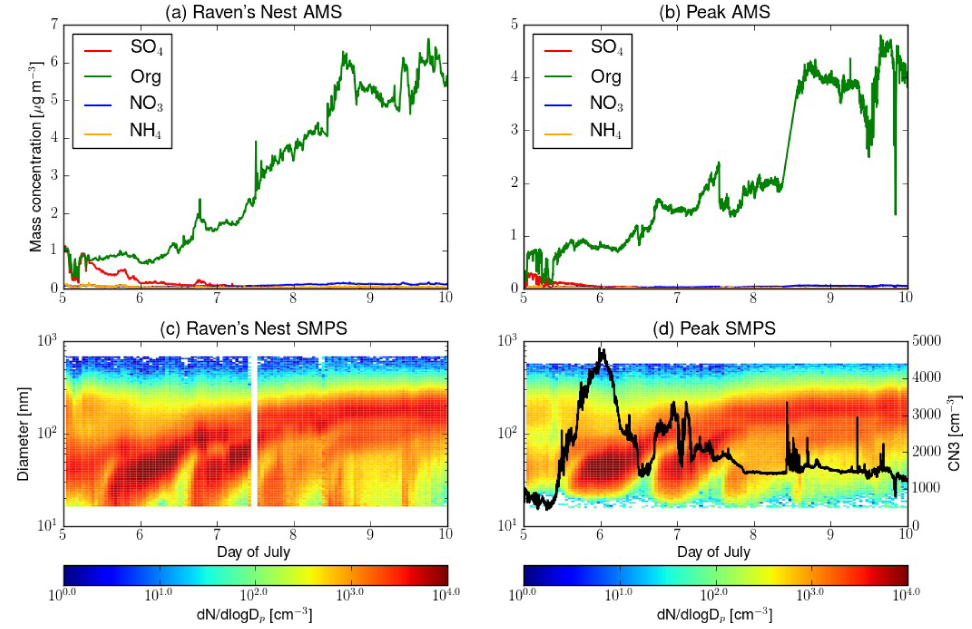
Fig. 2. (a) AMS mass timeseries at Raven’s Nest. (b) AMS mass timeseries at Peak. (c) SMPS size distribution timeseries at Raven’s Nest. (d) SMPS size distribution timeseries at Peak with the total number of particles with diameters larger than 3nm (CN3) measured by a CPC (black line) during the same period. The x-axes represent local Pacific daylight